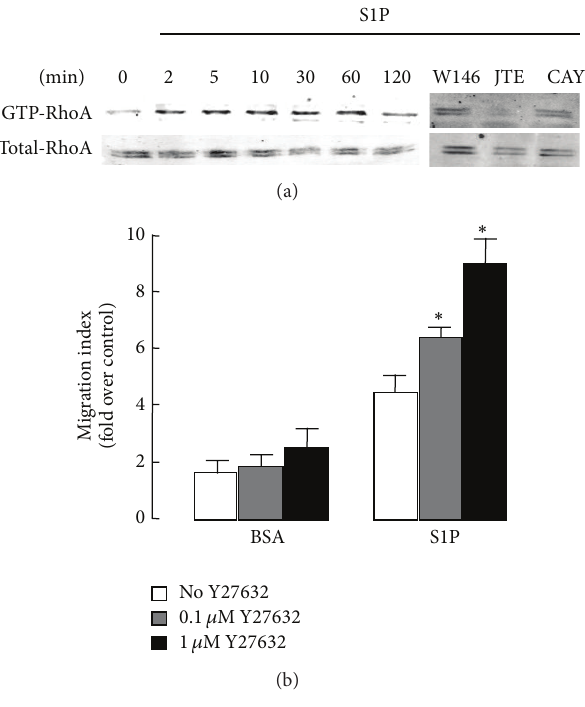
Figure 6: The essential role of the Rho pathway in S1PR2-mediated suppression of human BMSCs migration. (a) Left: cells were stim- ulated with S1P (1 𝜇 M) for the indicated time. Right: cells were pretreated with S1PRs antagonists (S1PR1 antagonist W146, S1PR2 antagonist JTE-013, and S1PR3 antagonist CAY1444) and then were stimulatedwith1 𝜇 MS1Pfor5min.RhoAactivitiesweredetermined by a pull-down assay. (b) Serum-starved BMSCs were pretreated with the indicated concentration of Y27632 and then were allowed to migrate for 4h in the presence of 1nM